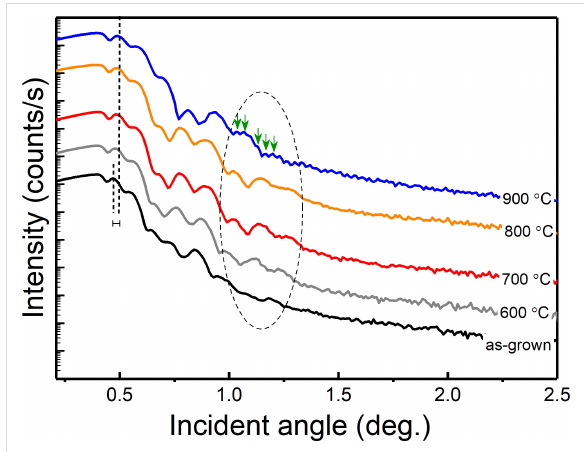
Figure 3: XRR plot for as-deposited and annealed (for 1 min) struc- tures. The vertical dashed lines illustrate the difference in incidence